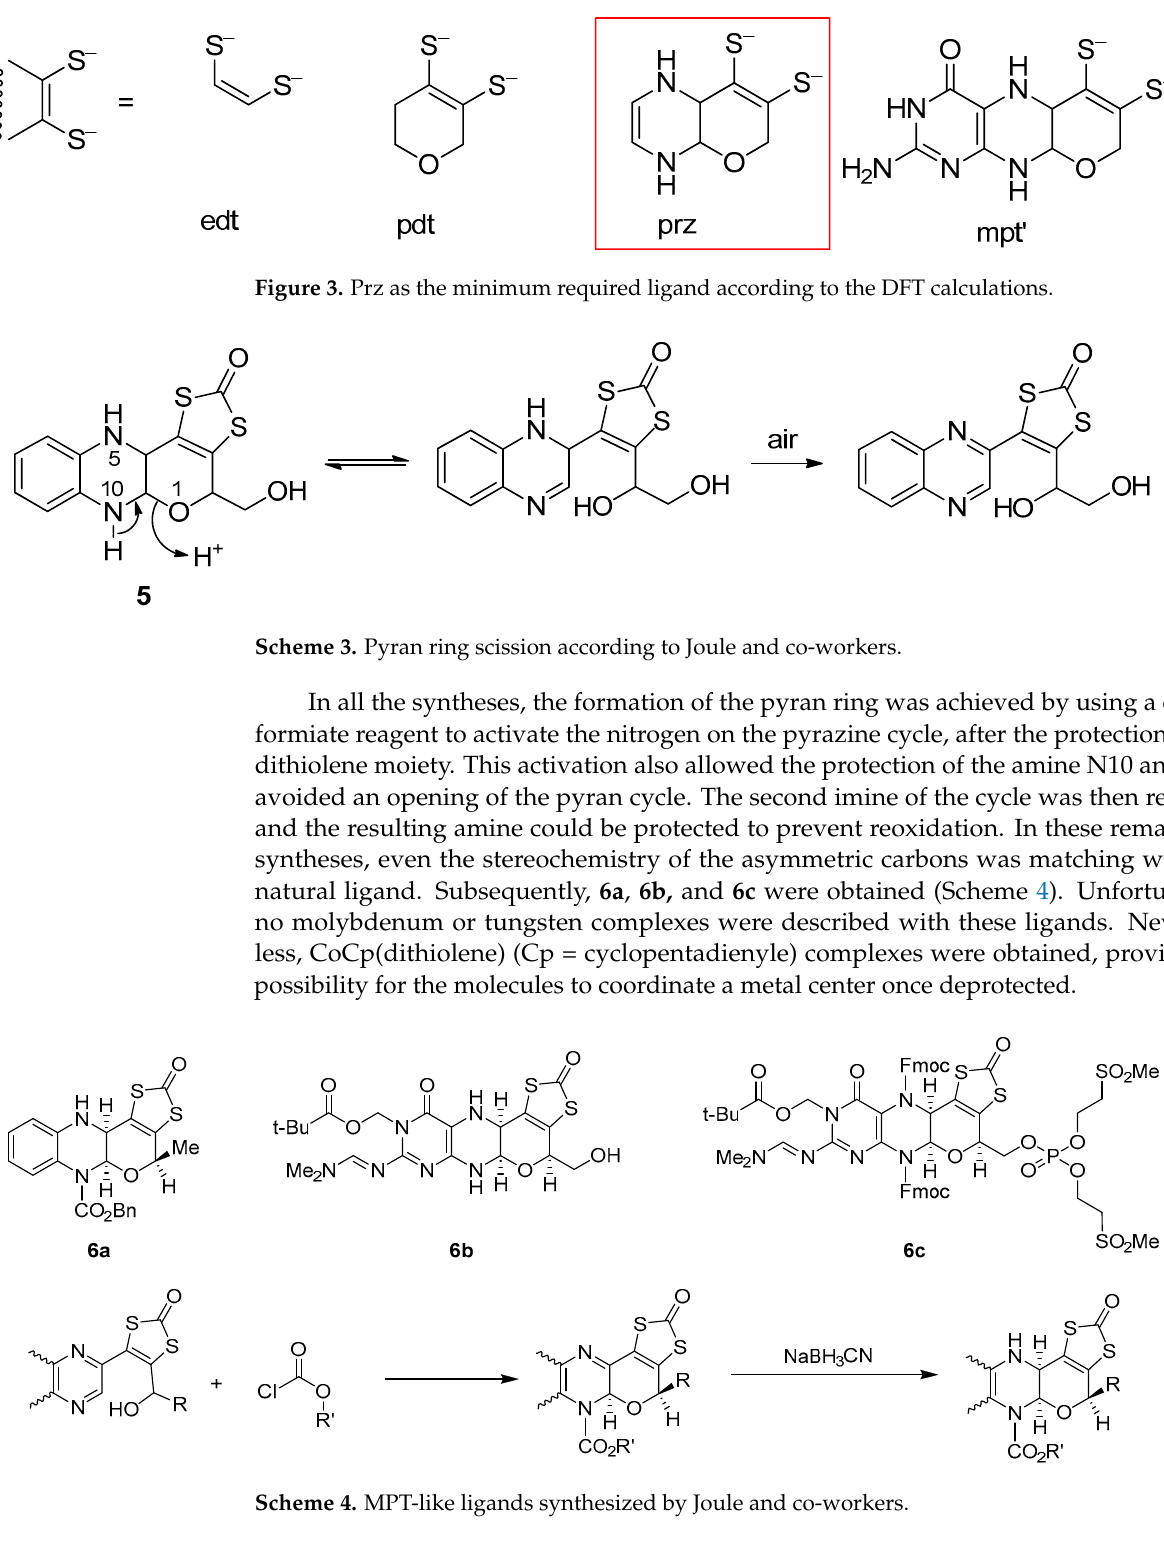
Figure 3. Prz as the minimum required ligand according to the DFT